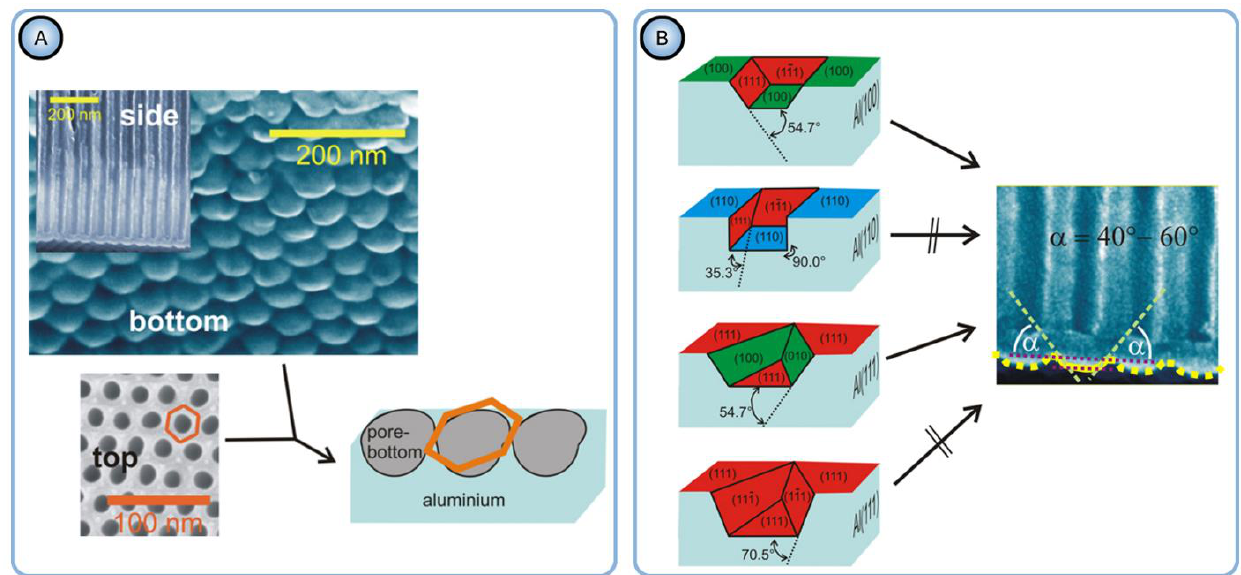
Figure 8. ( A ) SEM images demonstrating the bottom (sealed with the barrier layer), the lateral, and the top (porous) sides of PAA, as well as a schematic sketch of the hemispherical concaves on the Al surface underlying the pore bottoms; ( B ) A comparison of indentations on (111), (110), and (100) Al faces in terms of the resulting interface energy reduction and the correspondence of the angles between different planes to the microscopically observed pore tip geometry. Reproduced with permission from [97]. Copyright 2011 Elsevier.